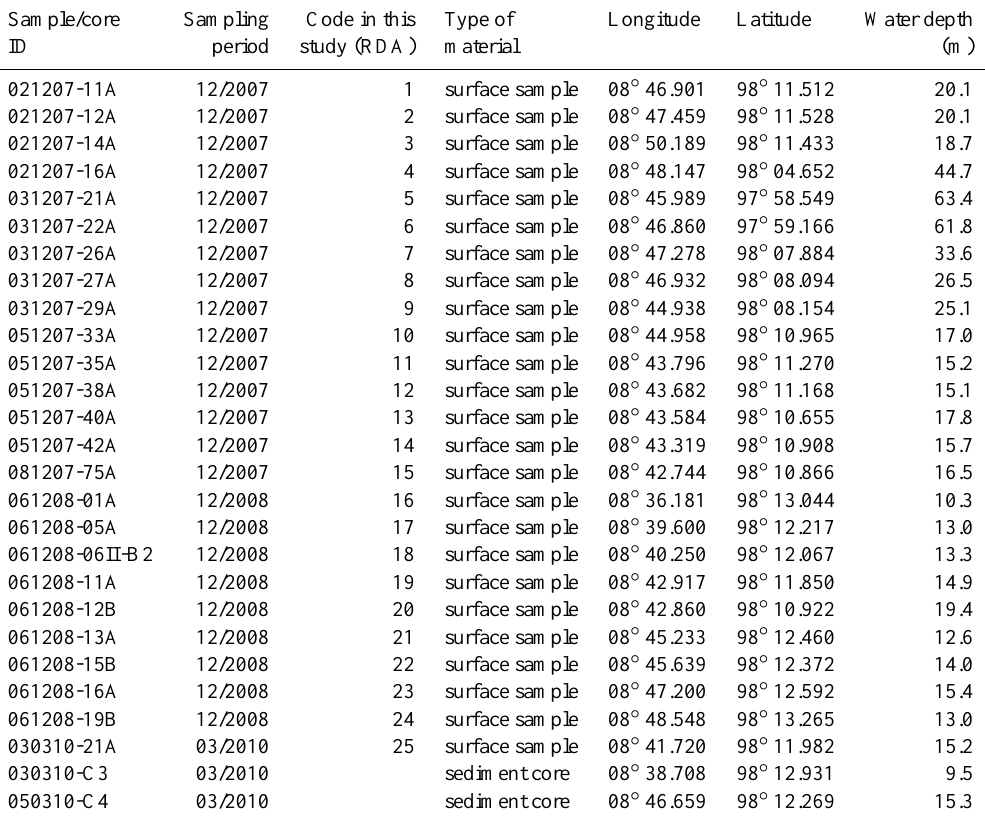
Table 1. Surface sample and sediment core IDs, sampling year, longitude and latitude, and water depth of the investigated surface samples and sediment cores (see also Fig.